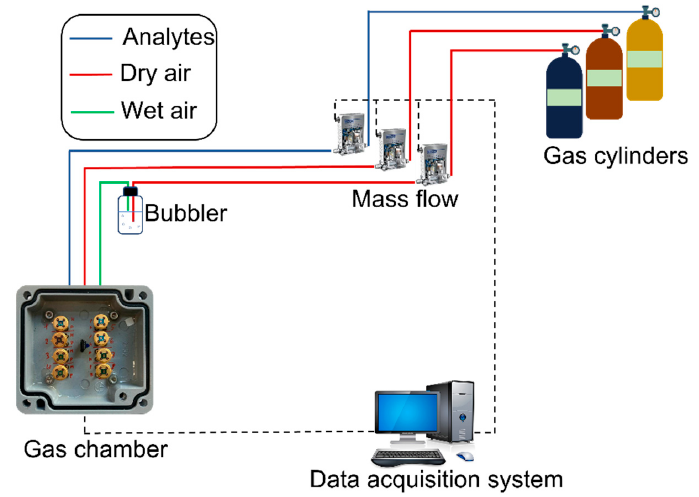
Figure 2. Schematic representation of the experimental gas sensor testing setup.